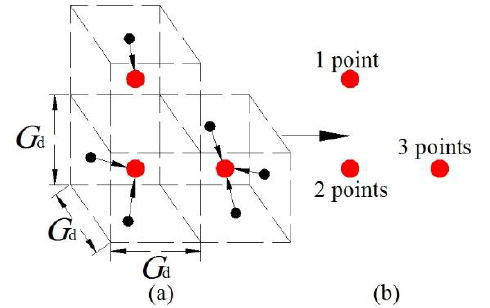
Figure 4 . Resampling method. a) Shifting the original points inside each voxel towards the voxel center, b) duplicate grid points. The black points are the point cloud. The red points are the grid points.